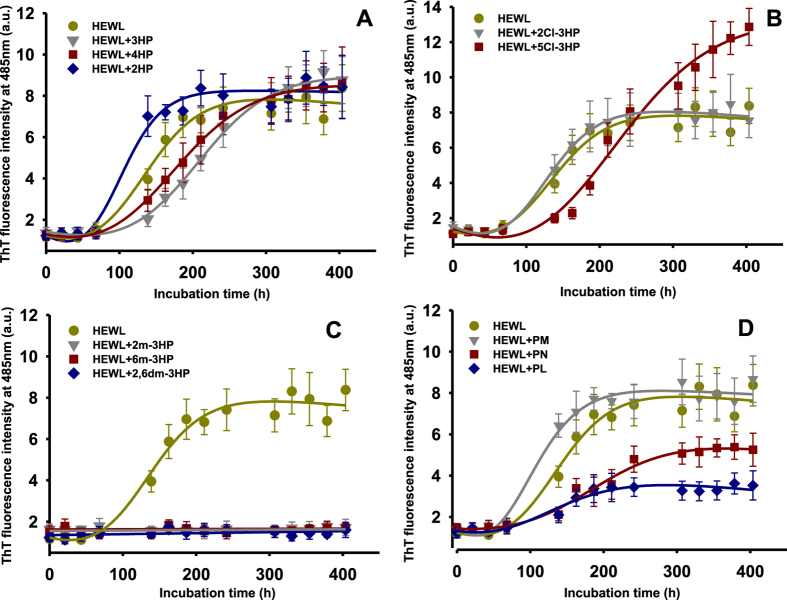
Effect of the different HPs at 100-fold molar excess on acid-induced HEWL fibrillogenesis as monitored by ThT fluorescence.For clarity of the representation, the data are spread in four different panels, each one of them gathering (A) the structurally simplest HPs, (B) the chlorinated 3HPs, (C) the o-methylated 3HPs, and (C) the natural vitamin B6 derivatives. Experimental data represent the average ± s.d. (n = 3).